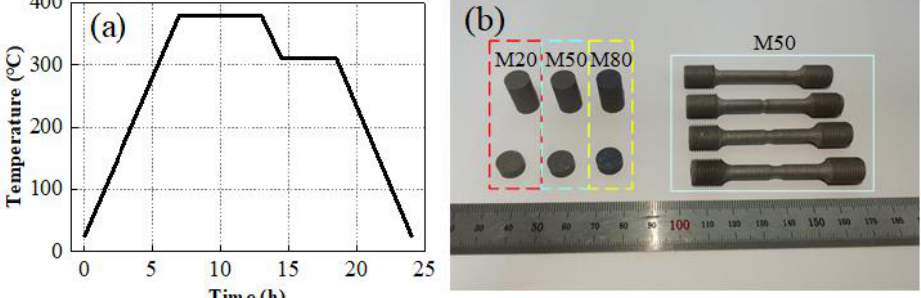
Figure 2. ( a ) Temperature history of sintering cycle and ( b ) typical specimens.